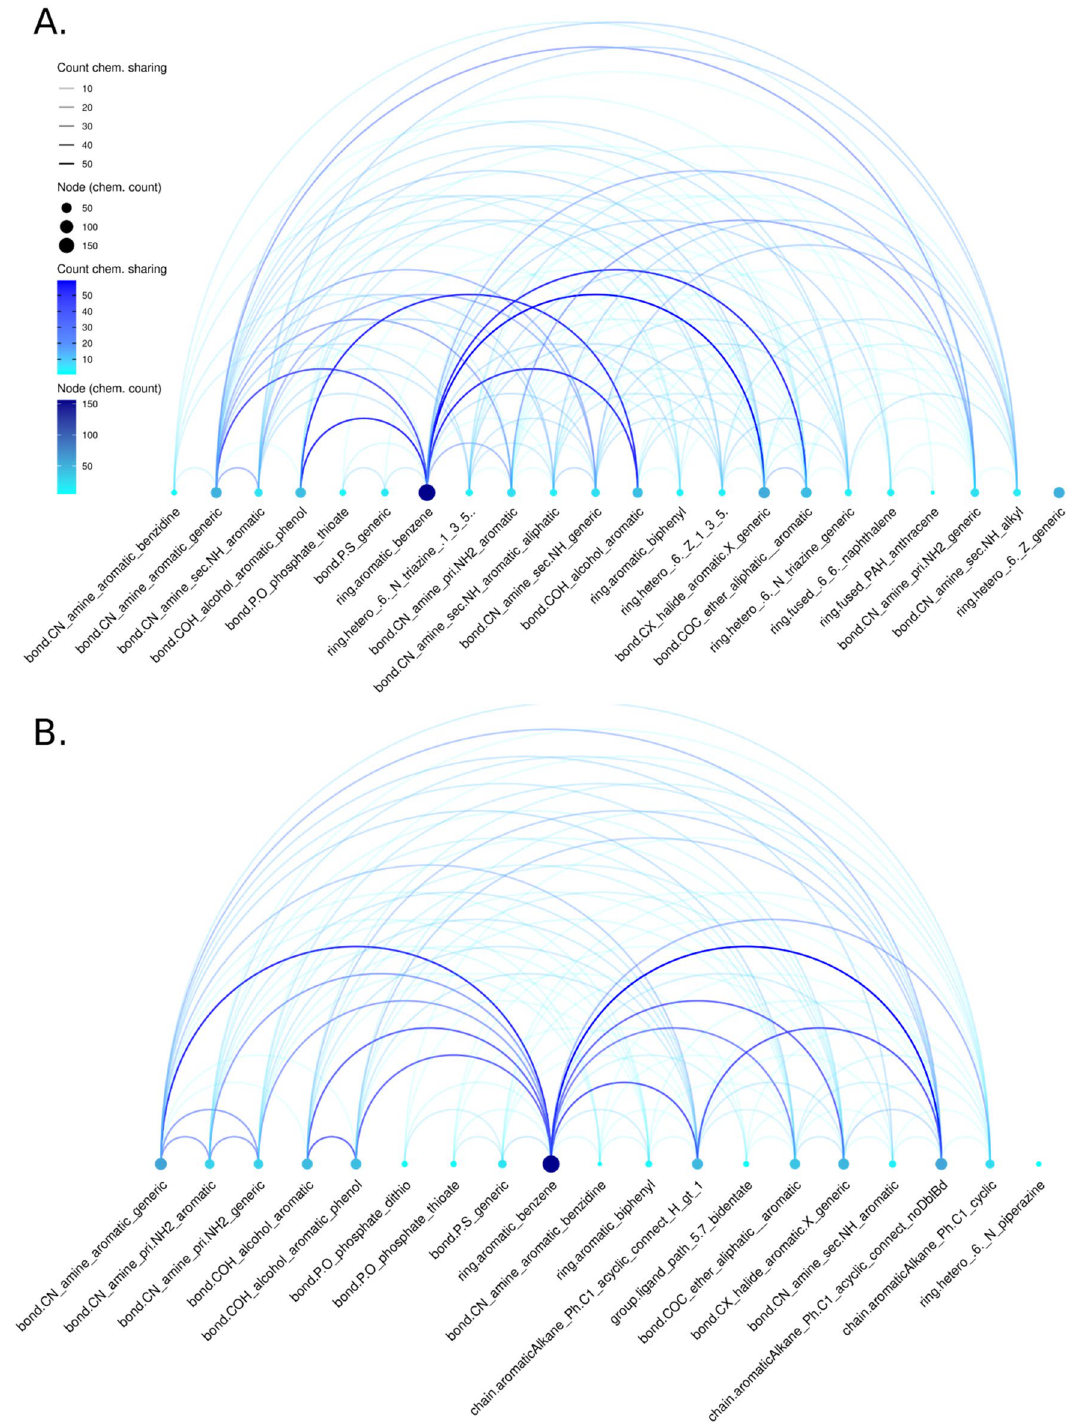
Figure 8. ToxPrint network for ( A ) E2up and ( B ) P4up chemicals. ToxPrints are represented by nodes colored by the number of the chemicals that included that ToxPrint. Combinations of ToxPrints are represented by the arc line colored based on the number of chemicals sharing these two ToxPrints. Only significant ToxPrints for E2up or P4up are represented (p-value <